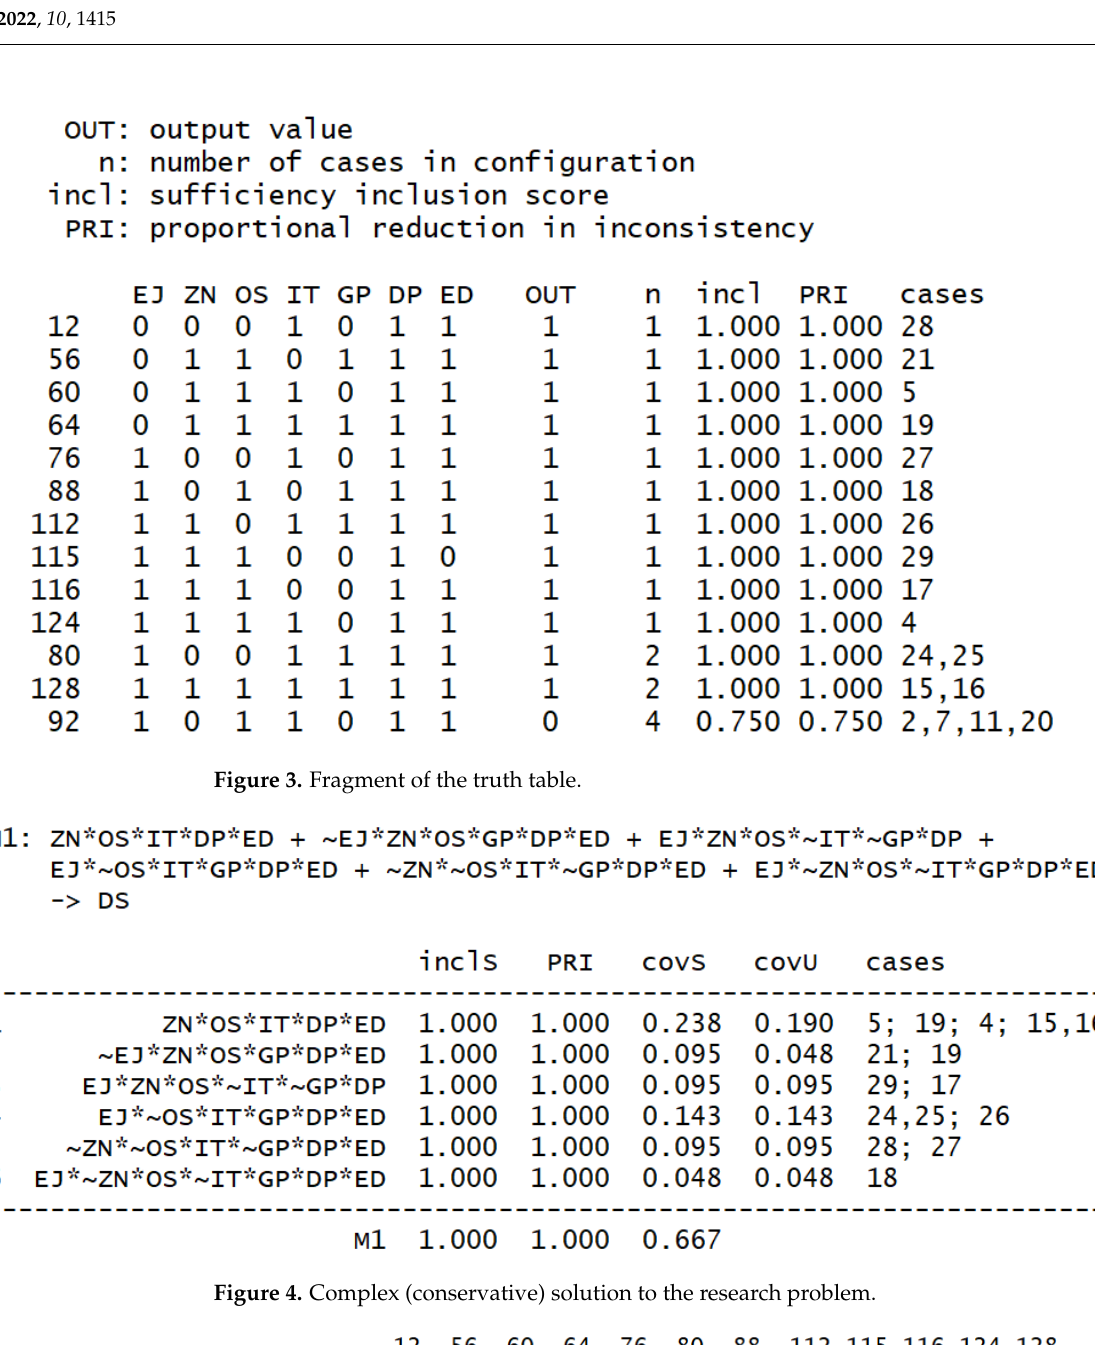
Figure 4. Complex (conservative) solution to the research problem.